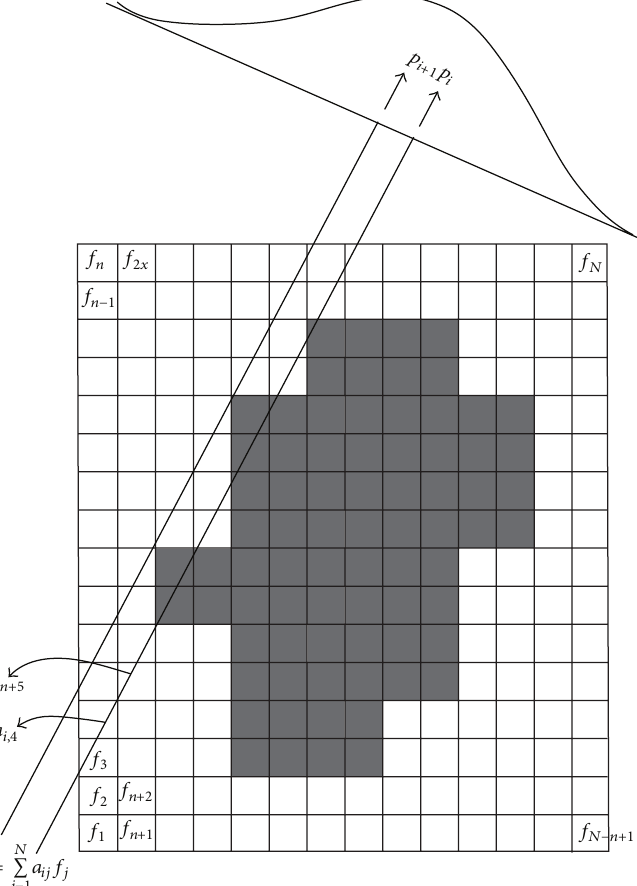
Figure 1: Our proposed CT image reconstruction method and its mathematical notations: 𝑏 𝑖 is the line integral of f along the ray 𝑝 𝑖 , and 𝑎 𝑖𝑗 is the length of the intersection of the ray 𝑝 𝑖 and the pixel 𝐼 𝑗